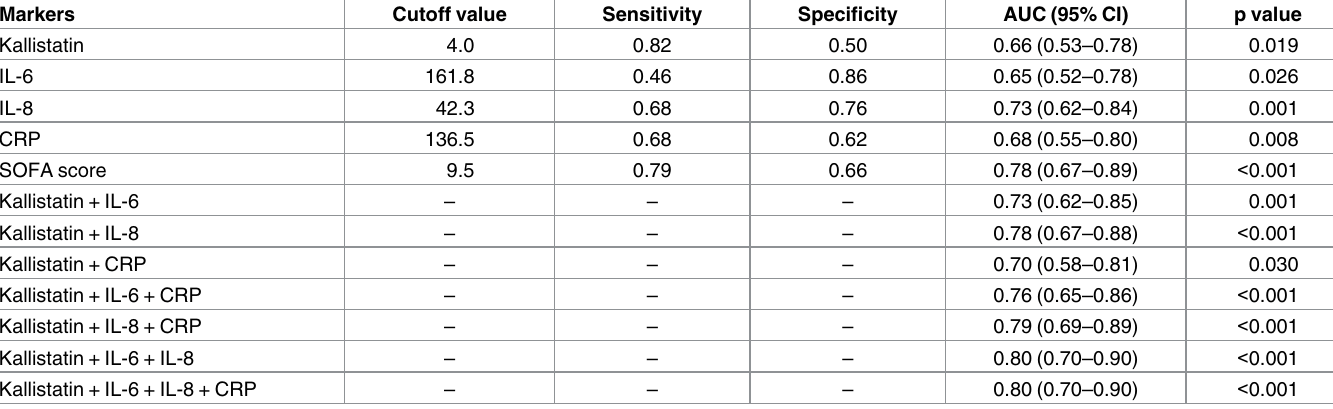
Table 4. ROC curve analysis for 60-day mortality prediction in severesepsis and septic shock